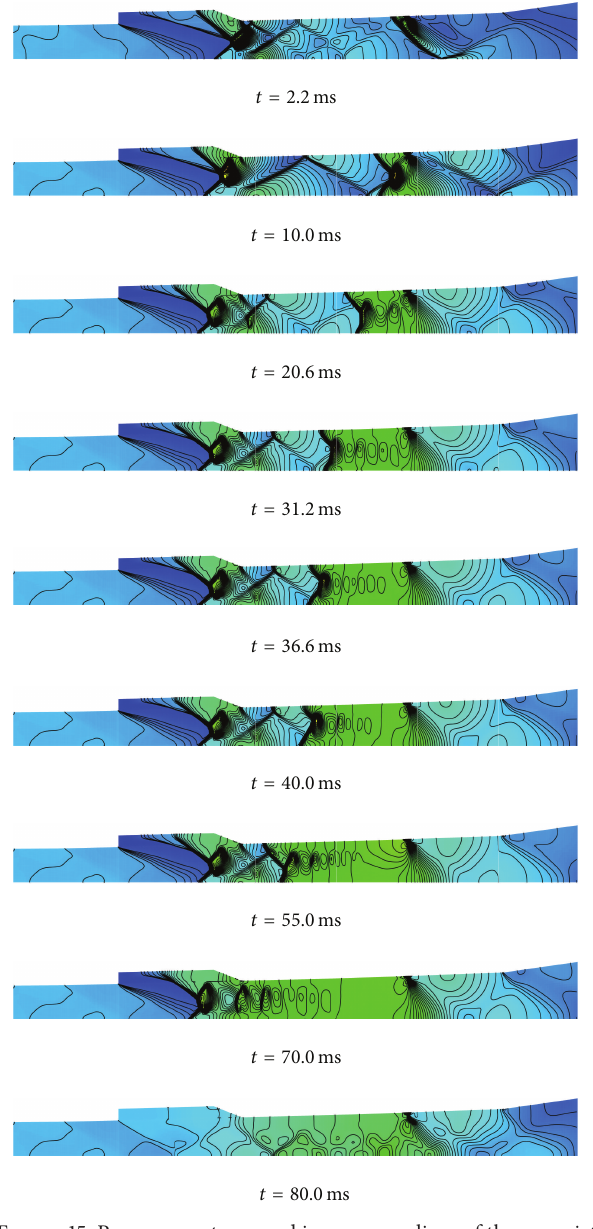
Figure 15: Pressure contours and iso-pressure lines of the scramjet combustor with air throttling at the location of 875 mm from the entrance of the combustor at different times.